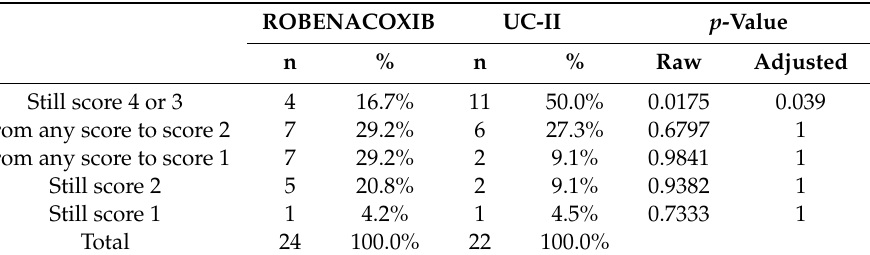
Table 2. Count and percentages of changes in the CLINICAL score recorded in the two groups of treatment from the beginning of treatment (T0) and after 30 days (T30). R = robenacoxib 1 mg / kg / day for 30 days; UC-II = undenatured type II collagen 1 tablet (40 mg) / day for 30 days.